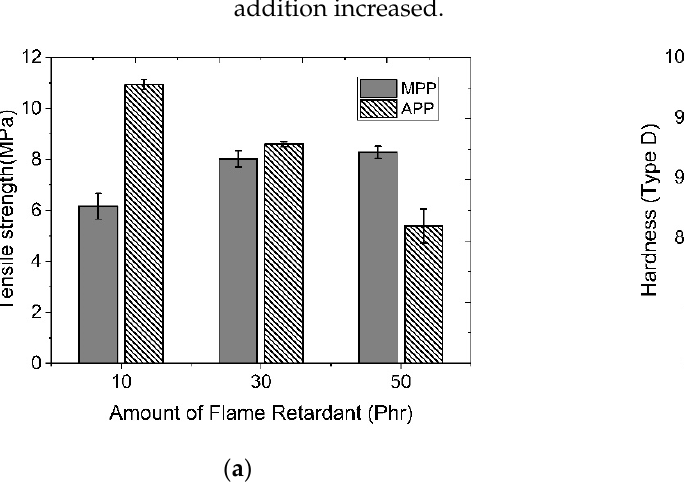
Figure 8. Comparison of physical properties depend on the flame retardant type (MPP, APP) and added contents: ( a ) tensile strength; ( b ) hardness.